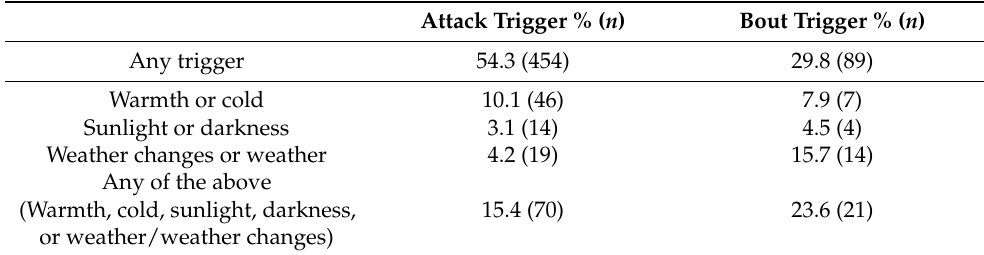
Table 1. Reported trigger factors for cluster headache attacks and bouts related to seasonal